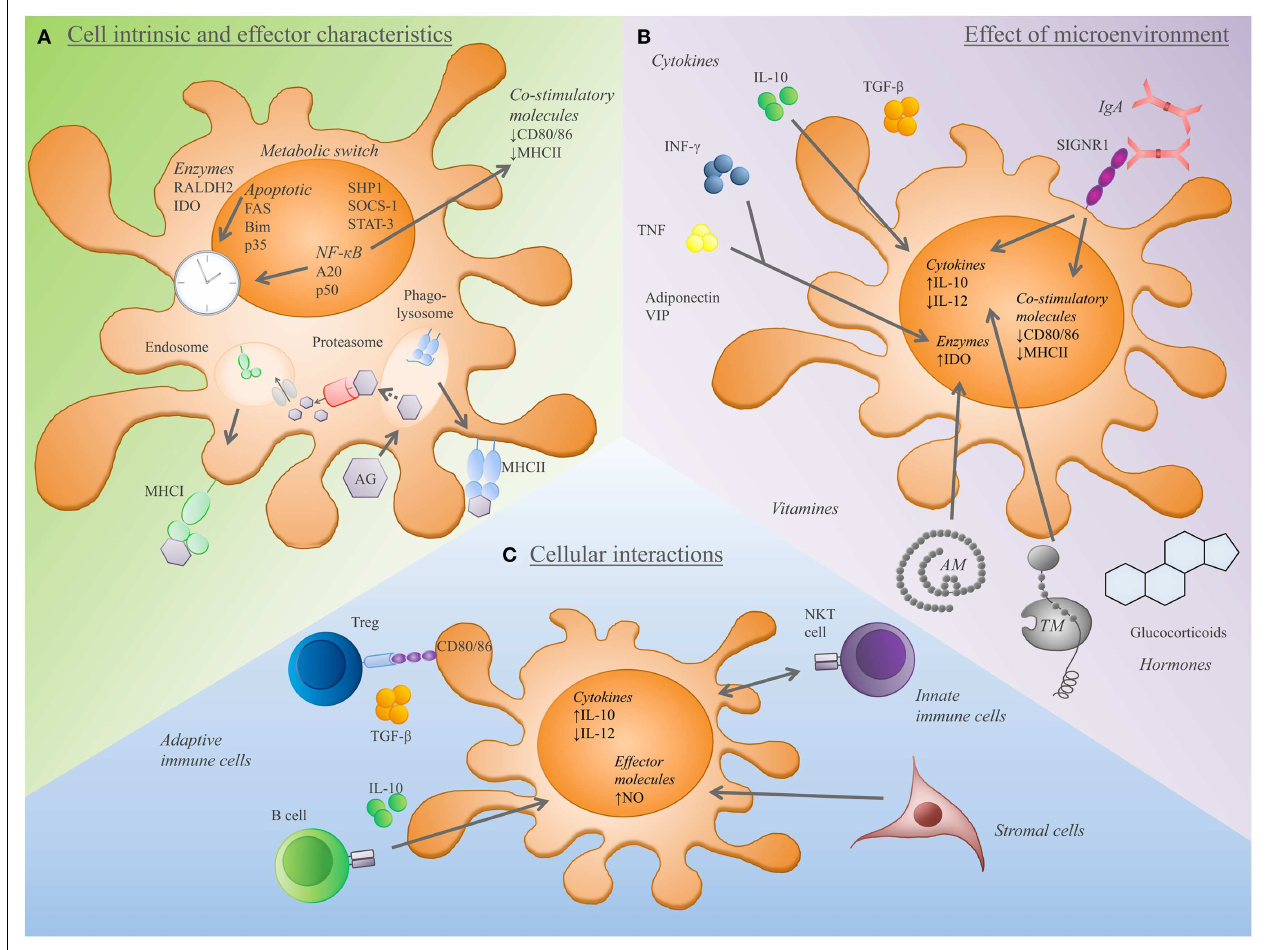
influence theT-cell inducing and tolerogenic capacity of DCs. (B) A variety of biological substances have an impact on tDC differentiation and function. Cytokines, vitamins, hormones as well as antibodies, thrombomodulin (TM), adrenomedullin (AM), andVIP induce tDCs. (C) The dialog of DCs with other immune cells and stromal cells provides additional checkpoints for the maintenance of tolerance. DC-Treg crosstalk involves the regulation ofTreg homeostasis, the activation and induction ofTregs.Tregs, IL-10 expressing B cells, and natural killerT (NKT) cells favor a tDC phenotype. In addition, stromal cells promote tDC differentiation toward IL-10 or nitric oxide (NO) producing regulatory